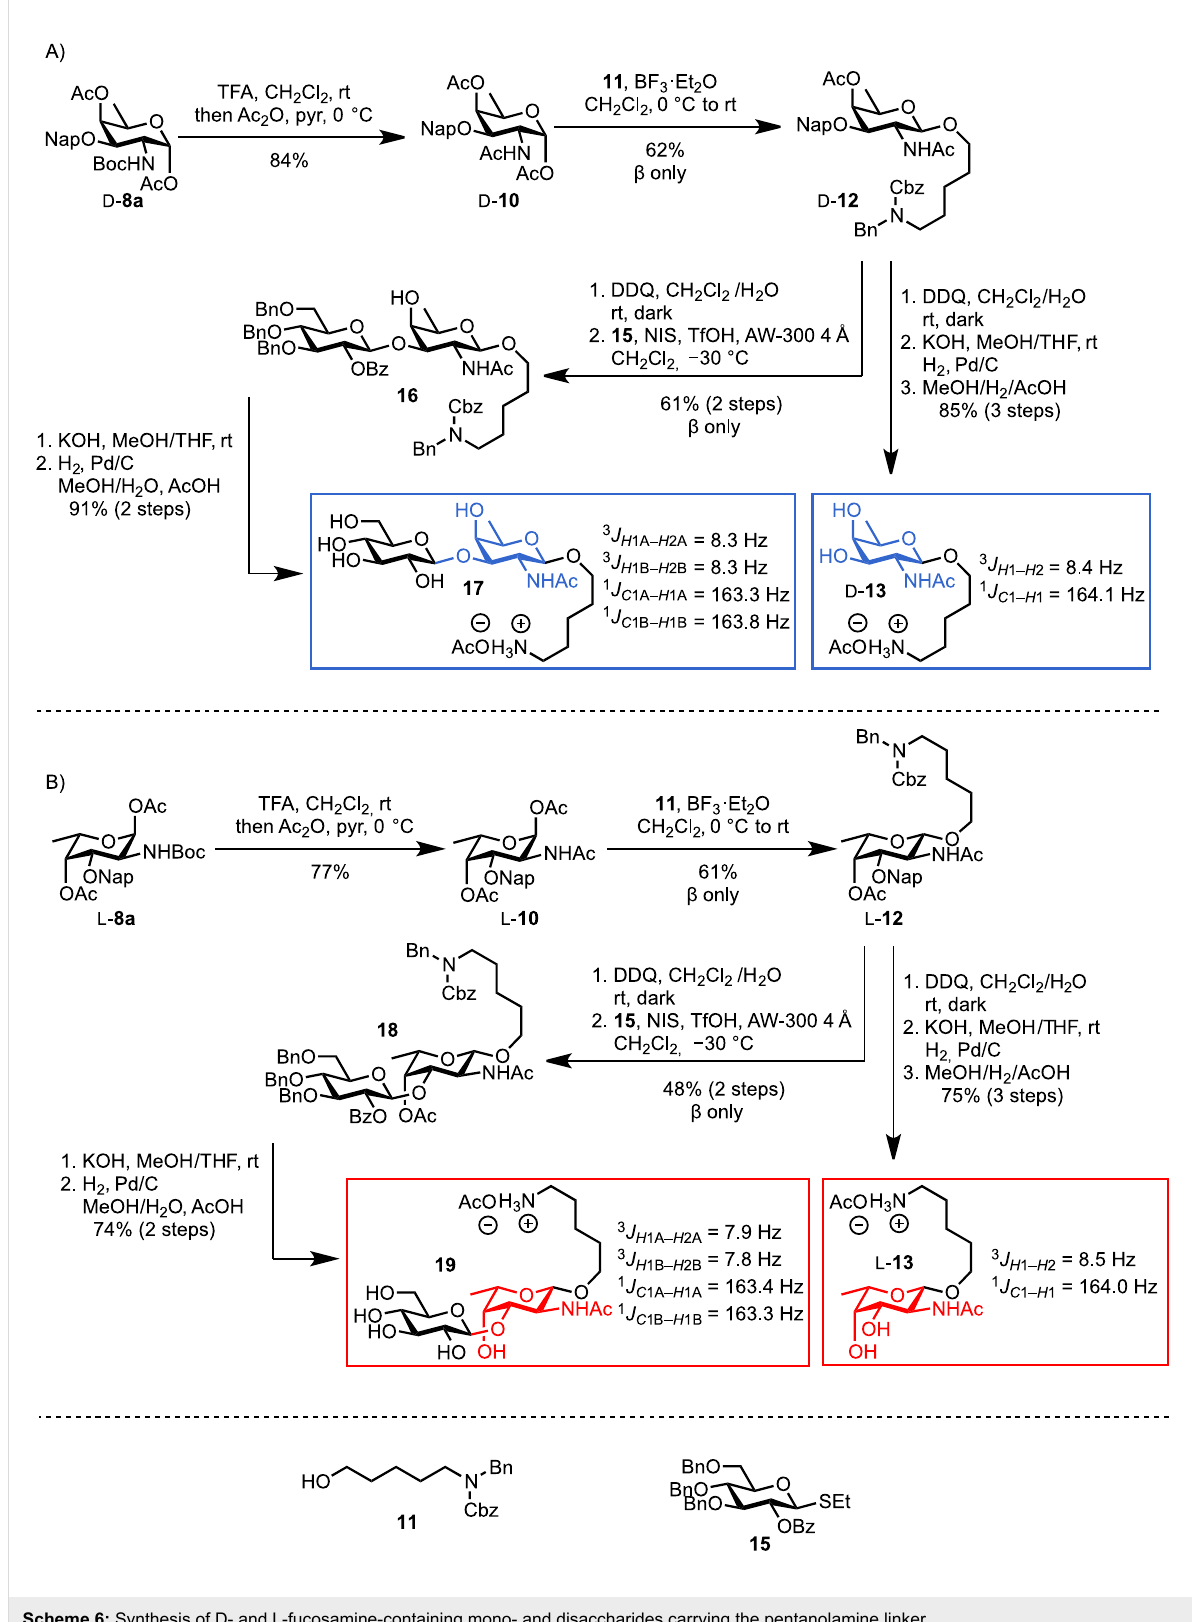
Scheme 6: Synthesis of D- and L-fucosamine-containing mono- and disaccharides carrying the pentanolamine